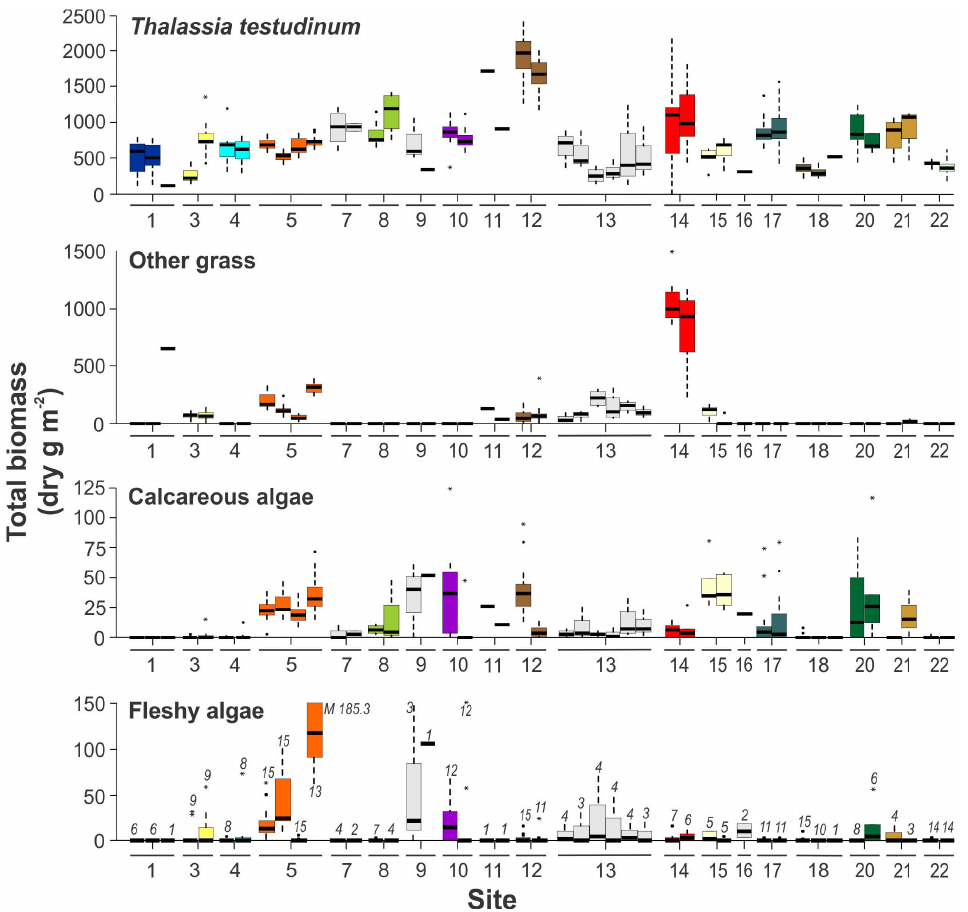
Figure 3. Total (above- and below-ground) biomass of the principal components of the community per sampling station grouped per site. Other grass: species of seagrass other than Thalassia testudinum , mostly Syringodium filiforme . Somatic (decalcified) above-ground weight of the calcareous algae is considered. The boxes and bars represent inter-annual variation, and stations with only one sampling event are excluded. The digits above the bars in the bottom graph indicate N (the number of sampling years). M median of fleshy algae at site 5-station 13. See legend of Fig. 2 for further explanation.